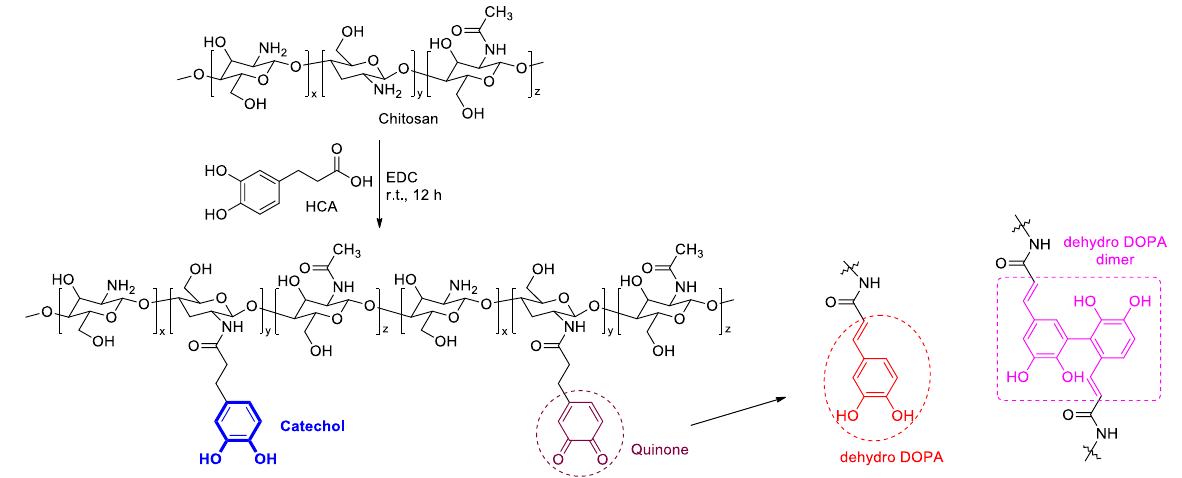
Figure 2. Synthesis of Cat-Chit and possible cross-linking pathways of catechol.